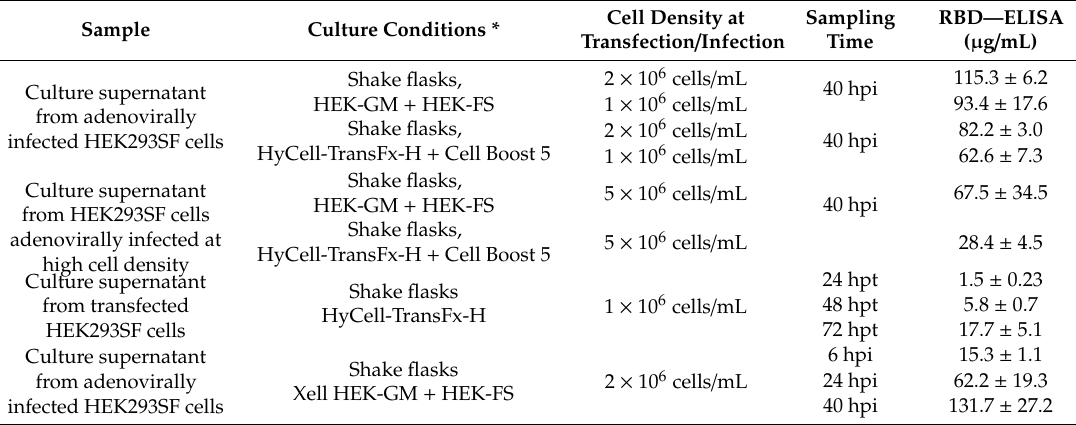
Table 1. RBD expression levels determined by ELISA in the supernatant of HEK293SF cells cultured under di ff erent conditions in suspension and serum-free